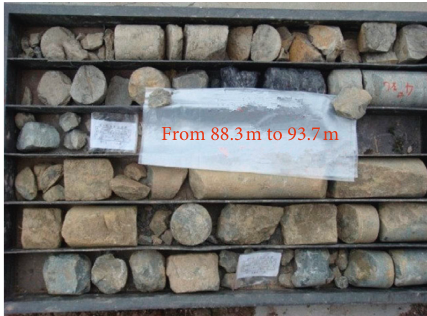
Figure 4: Characteristics of the borehole core in the middle section. Table 1: Test results of the mechanical properties of the rock samples.